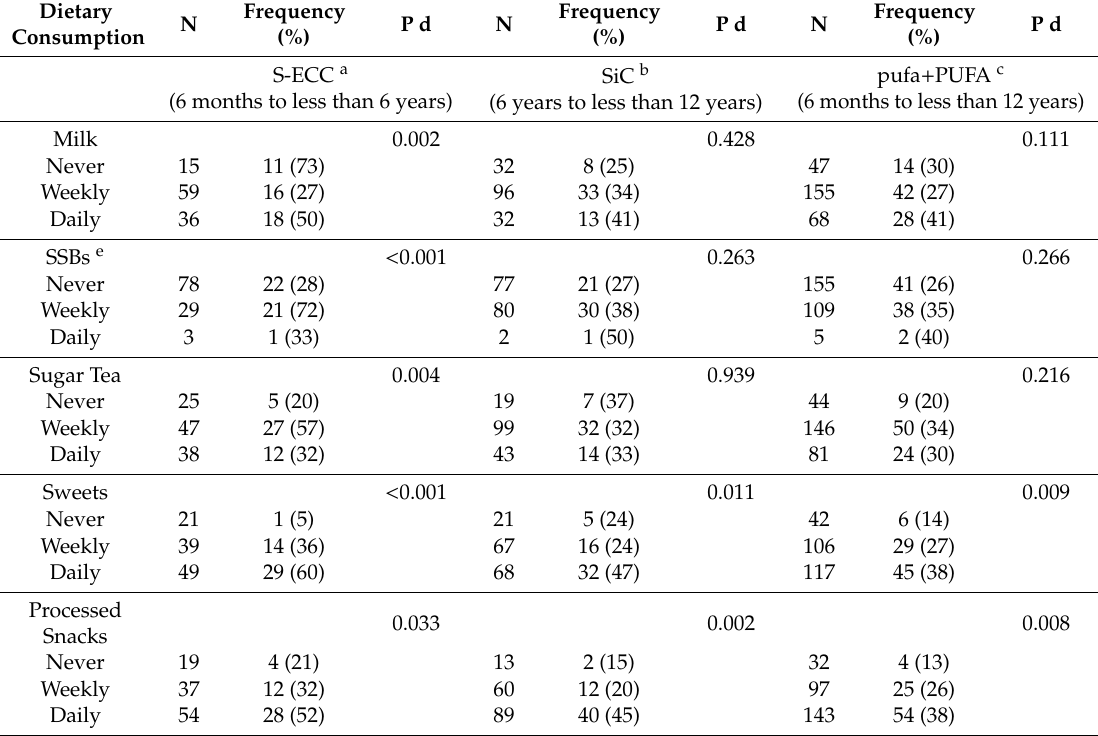
Table 3. Association between Dietary Consumption and Severe